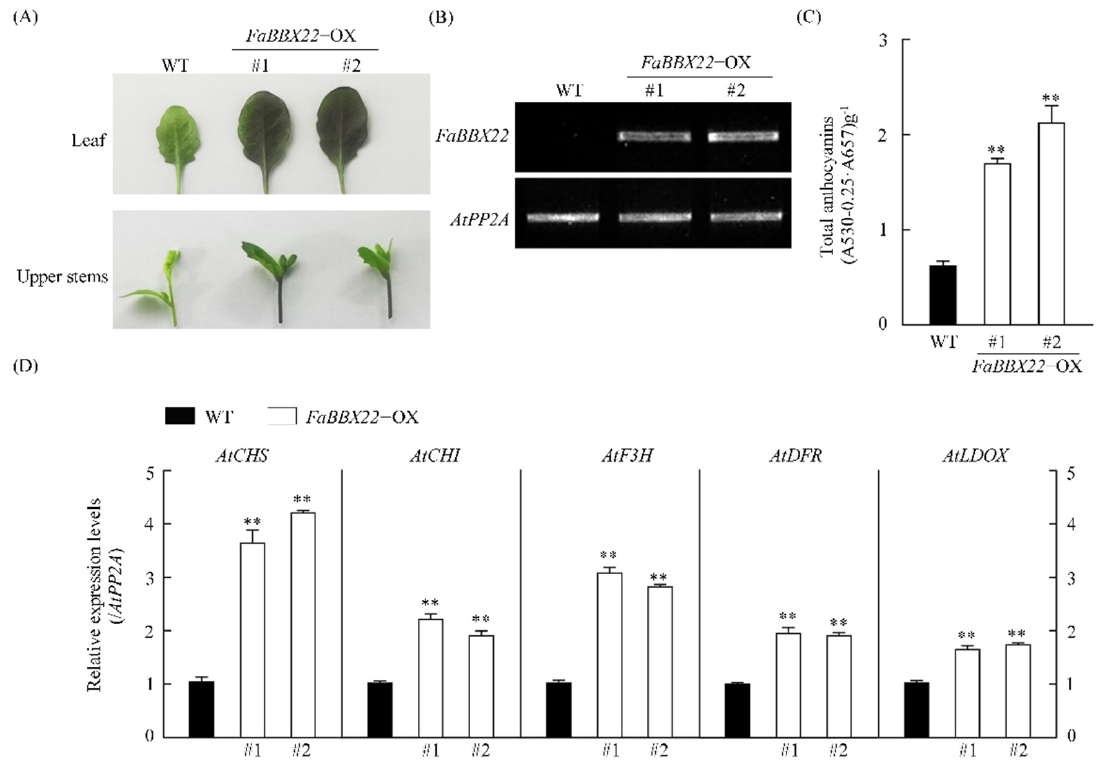
Figure 4. Effects of FaBBX22 ’s ectopic expression in Arabidopsis . ( A ) The phenotype comparison of wild − type (Columbia − 0) and transgenic Arabidopsis . FaBBX22 − OX represent FaBBX22 overexpres- sion lines. Two independent transgenic lines were used in the experiment; ( B ) The relative expression levels of FaBBX22 by semi − qRT − PCR; ( C ) Anthocyanins content, and ( D ) expression levels of antho- cyanin biosynthetic structural genes in wild-type and transgenic lines. Error bars represent the SD of three independent replicates. Asterisks indicate significant differences (two − tailed Student’s t − test, ** p < 0.01) compared with the wild-type control.